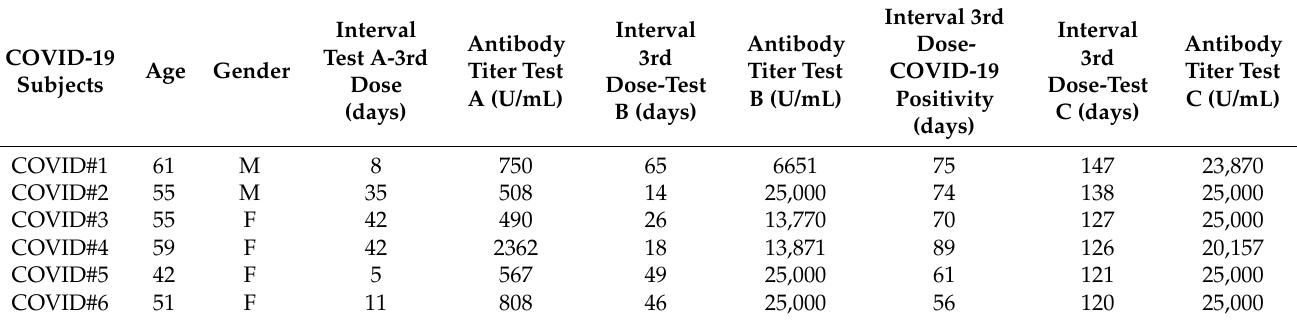
Table 2. Characteristics of the subjects resulted positive for SARS-CoV-2, antibody titers, time interval between booster dose, serological tests, and positivity. (Test A: prior booster; Test B: one month after booster; Test C: four months after